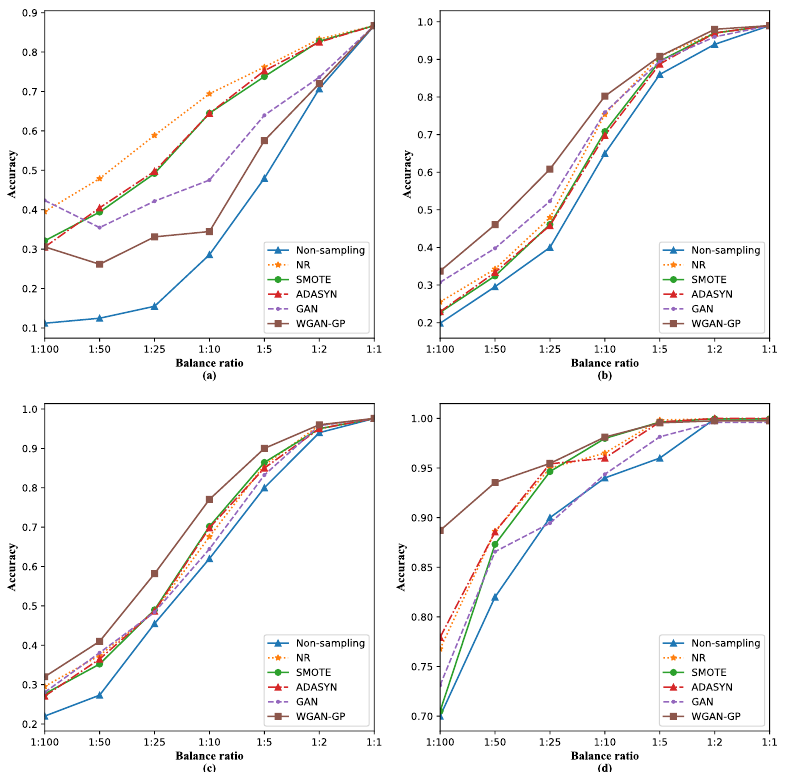
Figure 6. Diagnosis accuracy of multi-class imbalance fault dataset on HP = 0: ( a ) SVM model; ( b ) BP model; ( c ) DBN model and ( d ) CNN